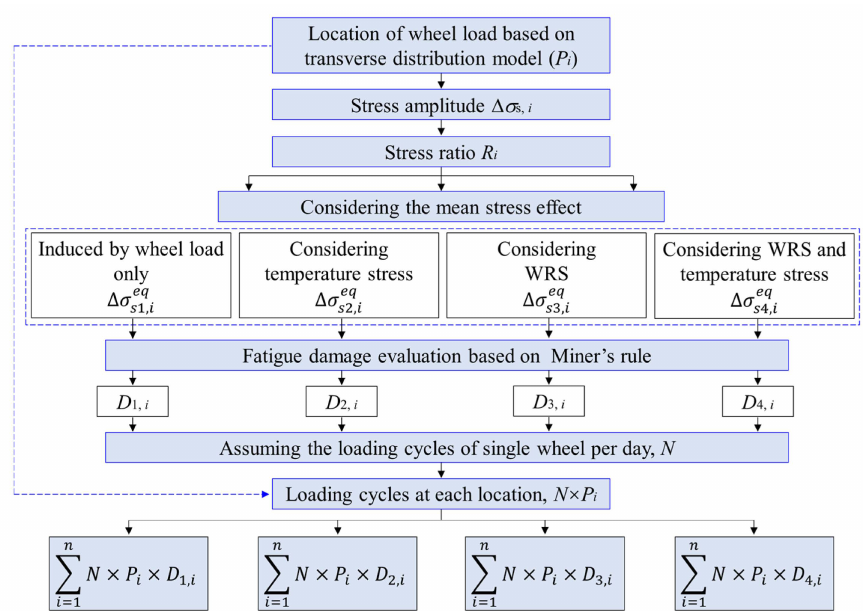
Figure 21. Flowchart of fatigue damage evaluation